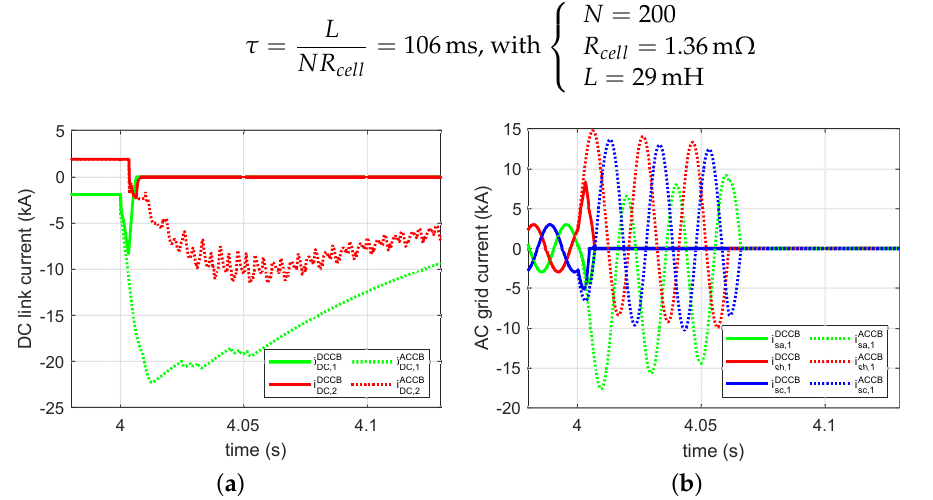
Figure 13. DC link current and AC grid currents during DC pole-to-pole fault with AC circuit- breakers (dotted lines) and DC circuit-breakers (solid lines). ( a ) DC link current - zoom - green for Converter 1, red for Converter 2, solid line for DC CBs and dotted line for AC CBs. ( b ) AC grid currents i s , i ( t ) , i ∈ { a ; b ; c } , green for phase a, red for phase b and blue for phase c, solid line for DC CBs and dotted line for AC CBs.